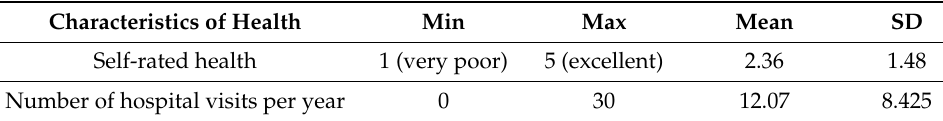
Table 2. Characteristics of health in the sample ( N = 146).